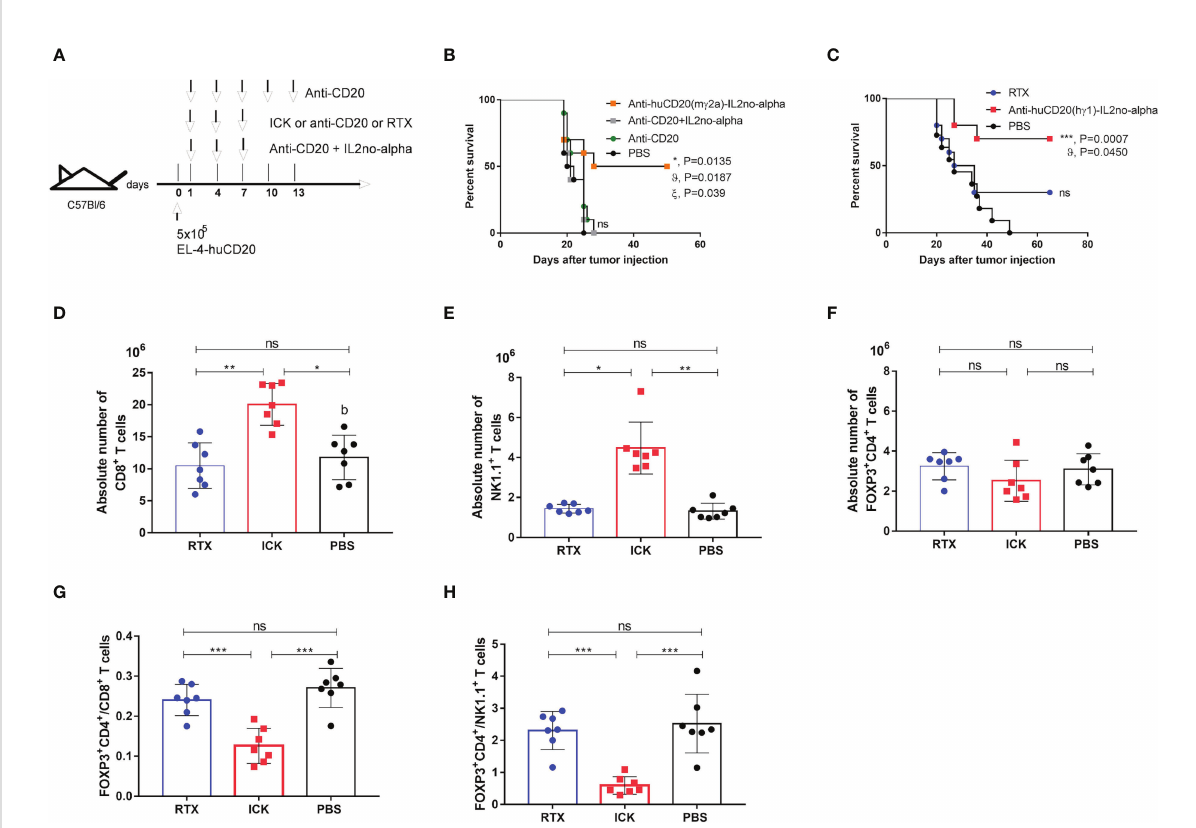
FIGURE 6 Effect of anti-huCD20(m g 2a)-IL2no-alpha and anti-huCD20(h g 1)-IL2no-alpha ICKs on survival of EL4-huCD20 tumor-bearing C57Bl/6 mice. (A) Schematic representation of treatment schedule. (B) Survival curves of mice with the different treatments as indicated: saline, anti-CD20 (16.6µg), anti-CD20 (16.6µg) + mutein IL-2no-alpha (3.3µg), anti-huCD20(m g 2a)-IL2no-alpha (20 µg). Data correspond to a representative experiment of two independent experiments (n=10 per group). (log-rank test; *, P< 0.05, anti-huCD20(m g 2a)-IL2no-alpha vs PBS; ϑ , P< 0.05, anti-huCD20(m g 2a)-IL2no-alpha vs (anti-CD20 + mutein IL-2no-alpha); x , P< 0.05, anti-huCD20(m g 2a)-IL2no-alpha vs anti-CD20; ns: not signi fi cant). (C) Low doses of anti-huCD20(h g 1)-IL2no-alpha (20ug) are more potent than equimolar dose of RTX (16µg). Data correspond to a representative experiment of two independent experiments (n=10 per group). (log-rank test; ***, P< 0.001, Anti-huCD20(h g 1)-IL2no-alpha vs PBS; ϑ , P< 0.05, Anti-huCD20(h g 1)-IL2no-alpha vs RTX; ns: not signi fi cant)). (D – H) Anti-huCD20(h g 1)-IL2no-alpha treatments expands NK+ and CD8+ cells over Tregs+. Absolute number of CD8+ T (D) NK1.1+CD3+ (E) and FOXP3+CD4+ (F) cells of splenocytes from C57Bl/6 mice evaluated by fl ow cytometry 11 days after challenge with 5x10 5 EL4-huCD20cells and treated with different therapies. (G, H) Mice receiving